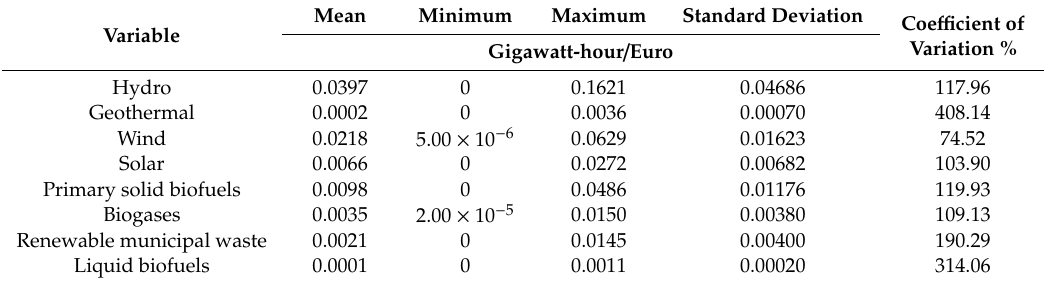
Table 6. Selected statistical parameters of variables determining the volume of energy production from renewable energy sources in the EU countries in terms of their GDP (by nominal expenditure, in euro) in 2017 (own